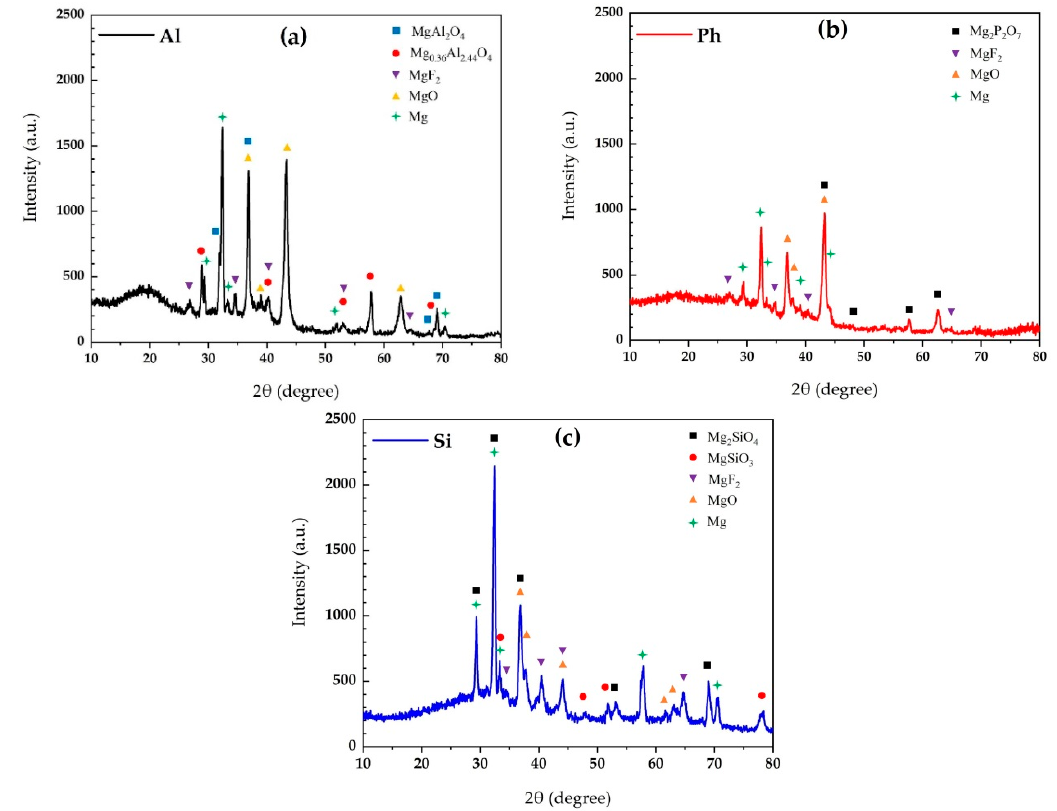
Figure 4. XRD patterns of PEO coatings produced at different electrolyte types: ( a ) Al, ( b ) Ph, and ( c ) Si.